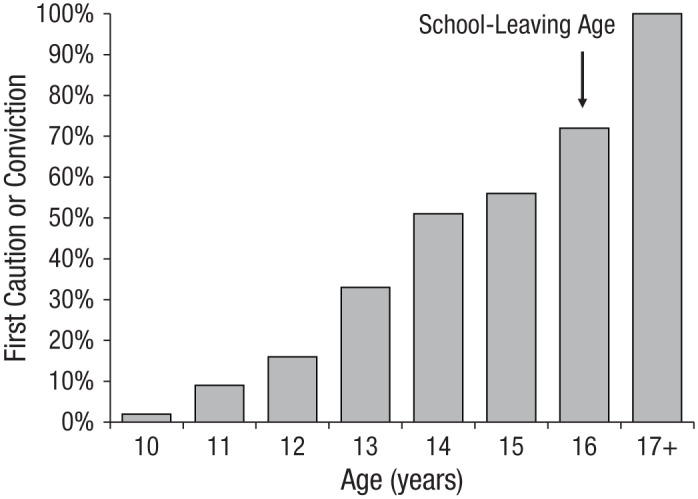
Cumulative distribution of the first appearance in police records of cautions and
convictions, by age, of the 196 participants with criminal records in the
Environmental Risk (E-Risk) cohort. In the United Kingdom, compulsory schooling ends
at age 16 years. The majority of E-Risk participants with criminal records received
their first caution or conviction before school-leaving age.